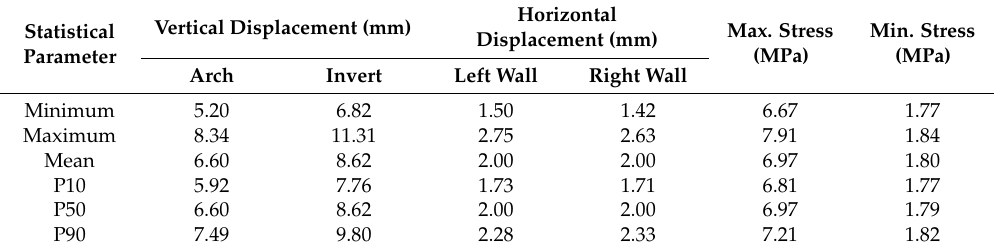
Table 5. Displacements and stresses values obtained for the 100 individual realisations.